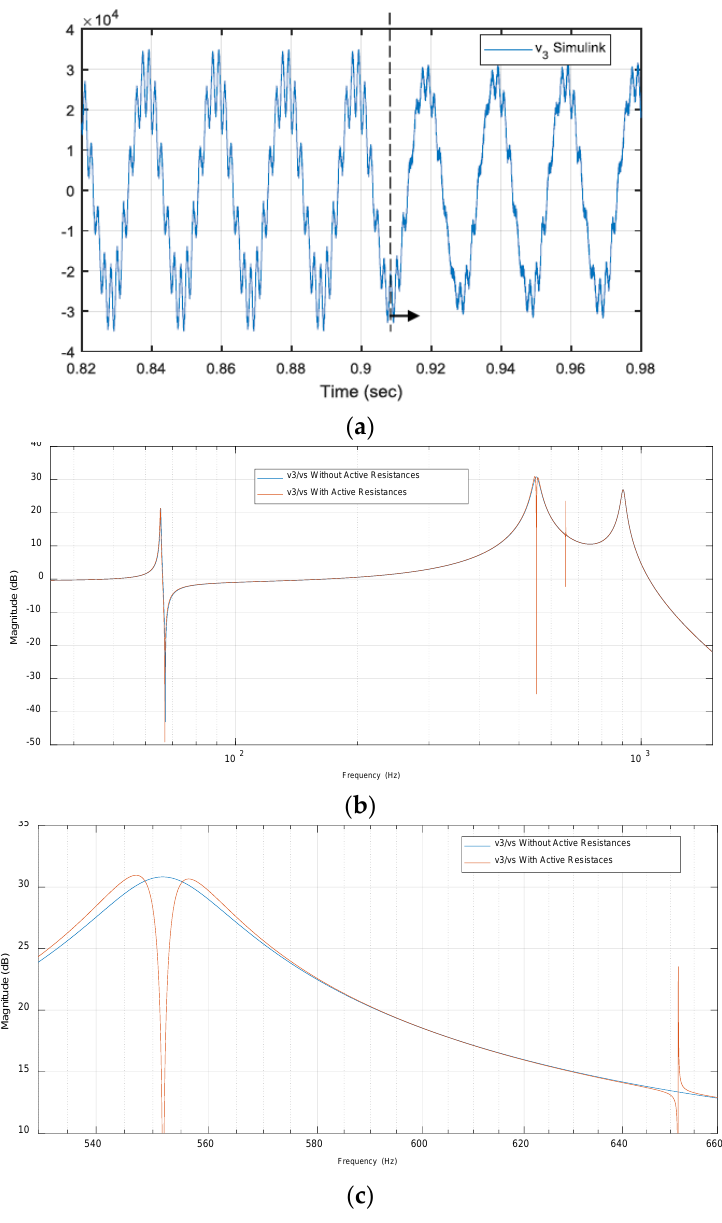
Figure 21. Performance evaluation ( a ) Voltage v 3 α at the Pcc, polluted with the 11th and 13th harmonics as a consequence of the harmonics emissions in the source voltage. At second 0.9, the ACISEF is enabled, operating with two active selective resistances: 10 Ω (at the low voltage side) to 550 Hz and 2.5 Ω (at the low voltage side) to 650 Hz. ( b ) Bode plot of v 3 αβ / v sαβ , with and without active resistances. ( c ) Magnification of the previous image.